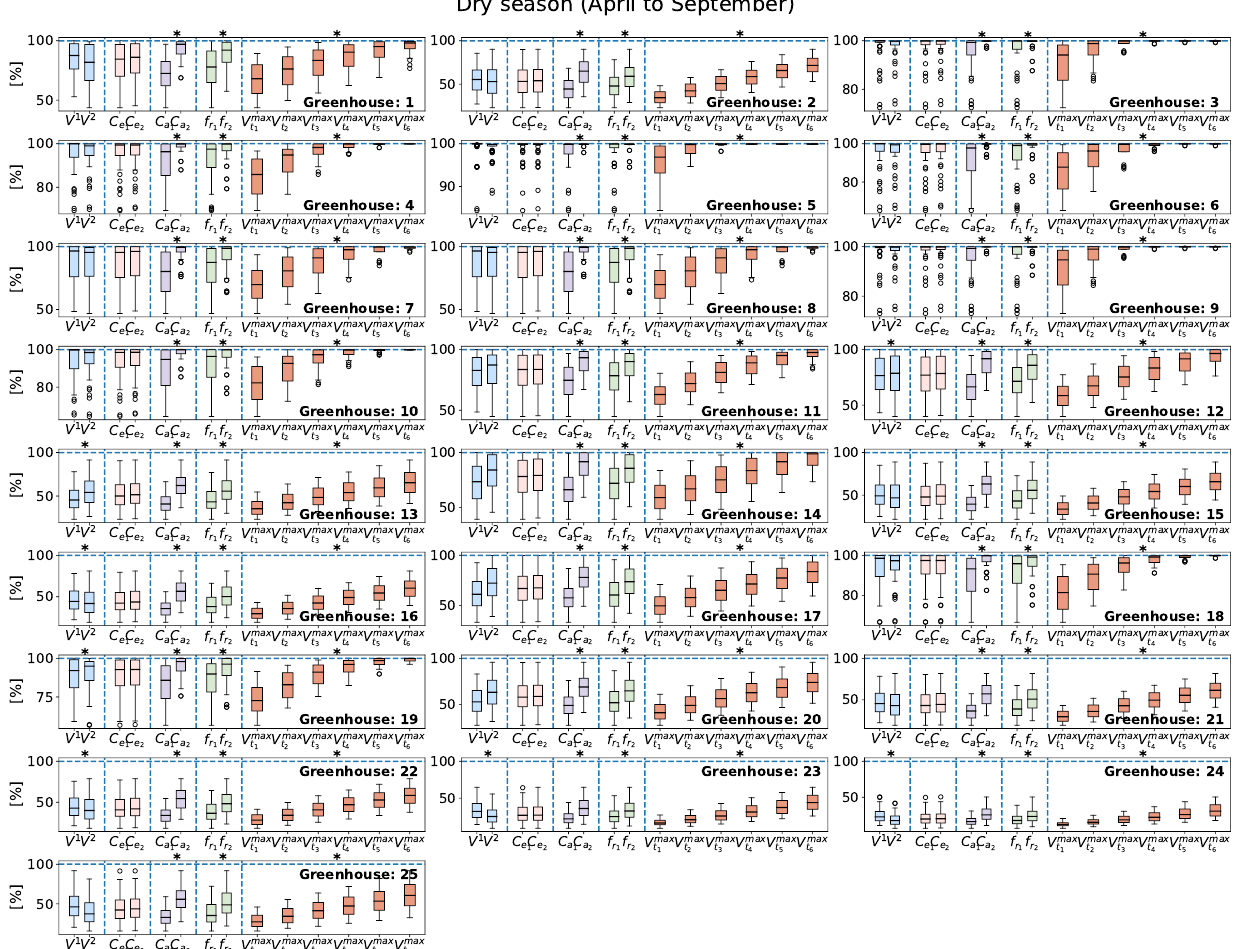
22–25 (Table 1), which are closer to the Copancara and Corpaputo rain gauges; (ii) The percentage of satisfied water demand is statistically insensitive to the changes in the runoff coefficient here explored for all greenhouses ( C e = 0.8, 0.9) and for both seasons. Mean values vary slightly for a given greenhouse (pink boxes in Figures 7 and 8); (iii) Time windows have a significant effect on seven greenhouses, mainly those associated with the Huayrocondo and Copancara rain gauges (blue boxes in Figures 7 and 8). The reason is that those stations have the largest difference in the number of rainy days between the two time windows selected (Table 2); (iv) The other three parameters (irrigation frequency, water volume used for irrigation, and maximum tank capacity) influence significantly at 95% over all greenhouses. Changes in irrigation frequency and volume of water used for irrigation may modify up to 20% the satisfied water demand percentage, depending on the greenhouse, while the maximum capacity of the tank can affect up to 30% the percentage of satisfied water demand, when we compare smaller with larger tanks (e.g., greenhouse 25).